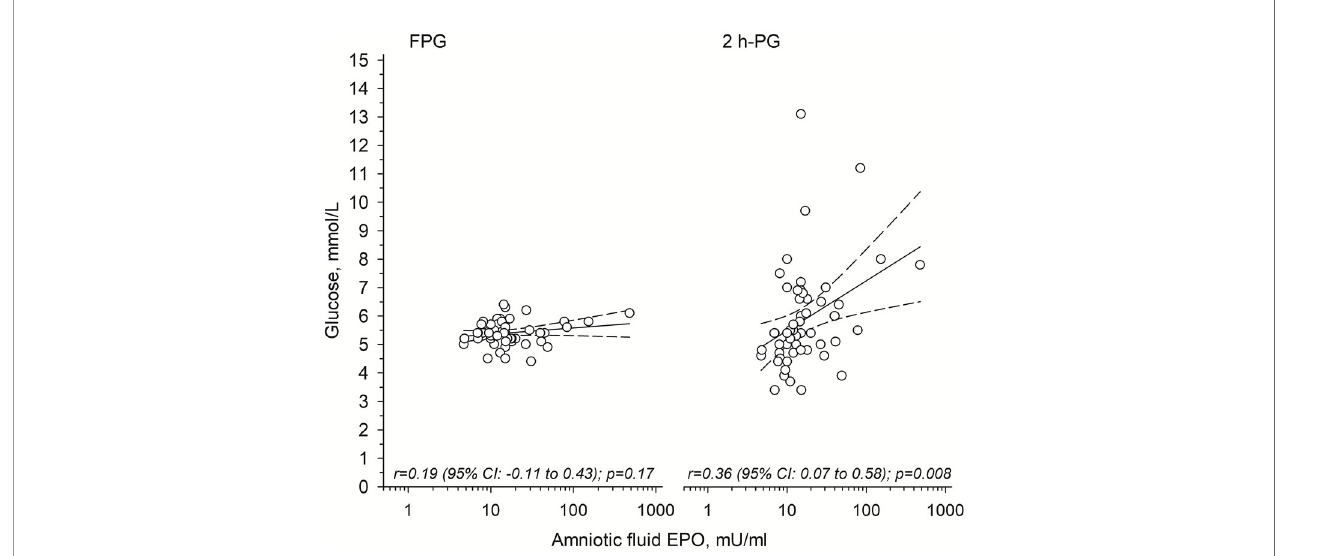
FIGURE 1 | Relationships between antenatally measured amniotic fl uid erythropoietin (EPO) and 1) fasting plasma glucose (FPG; left panel ); and 2) 2-hour post-load plasma glucose (2h-PG; right panel ) concentrations in young adult offspring of mothers with type 1 diabetes. Solid line shows the regression line and dashed line shows the 95% con fi dence